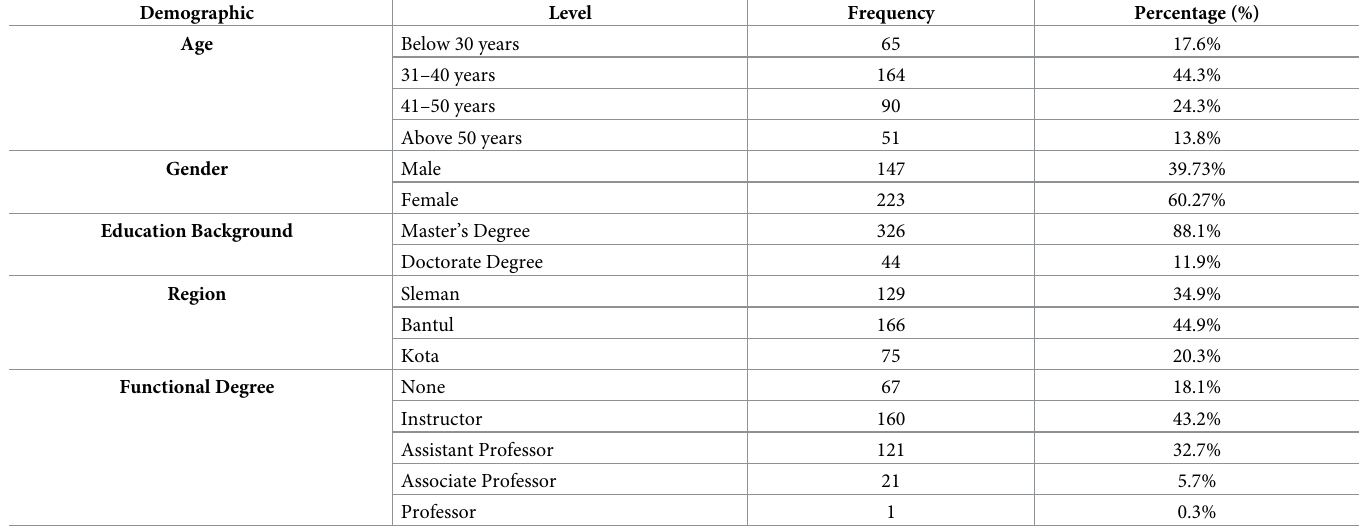
Table 1. Demographic profile of respondents of field